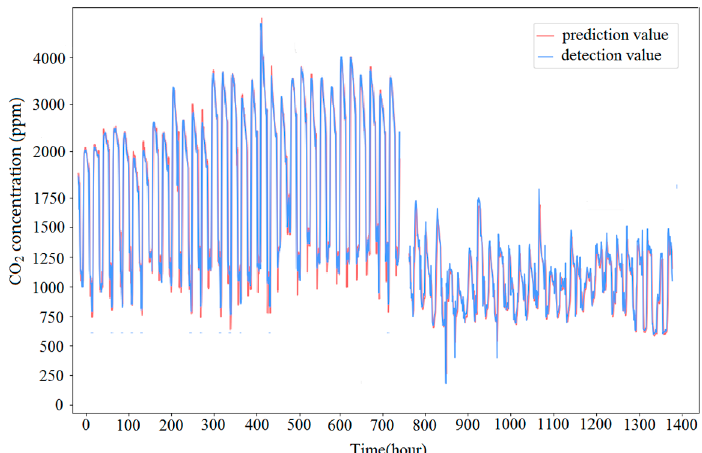
Figure 6. Prediction results of GRU model. Note: The data on the left are autumn and winter, the data on the right are spring and summer.